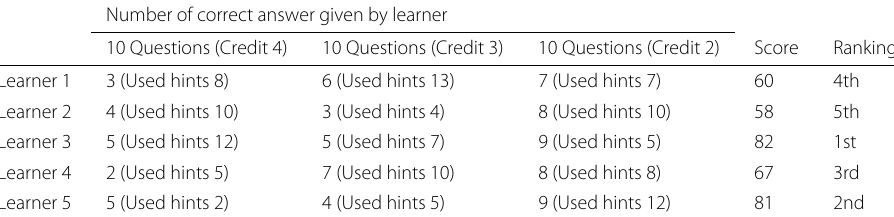
Table 5 Learner evaluation score and ranking (Total credit=180) Number of correct answer given by